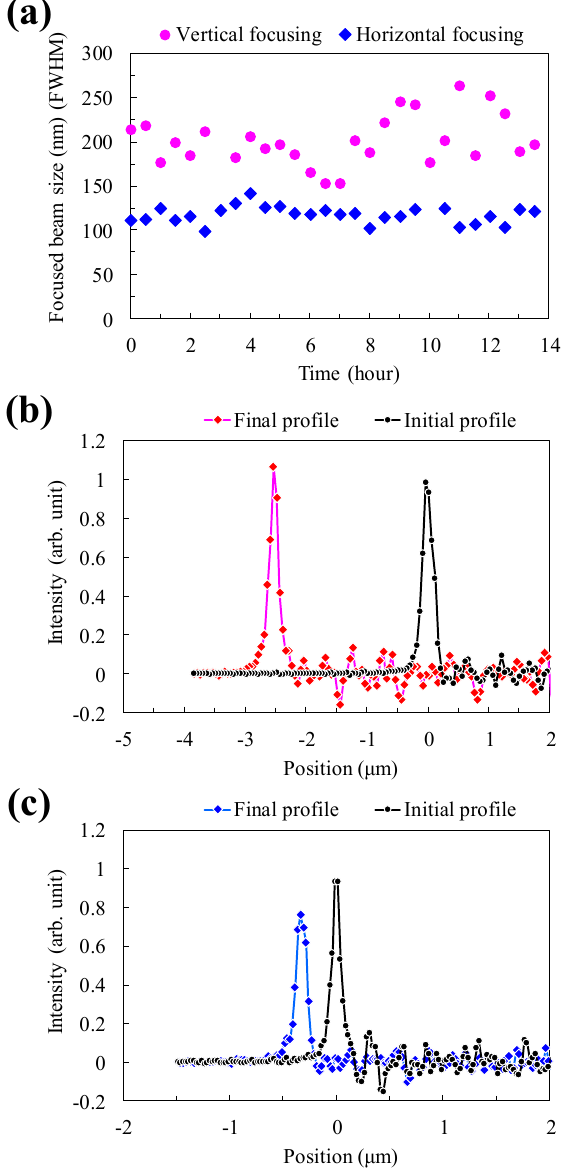
Figure 4. Measured stability of focused beam. ( a ) Time dependence of focused beam size. Root-mean-square deviation was 28 nm and 9 nm in the vertical and horizontal directions. ( b ) Focused beam profiles observed during stability evaluation, in the vertical direction and ( c ) horizontal direction.